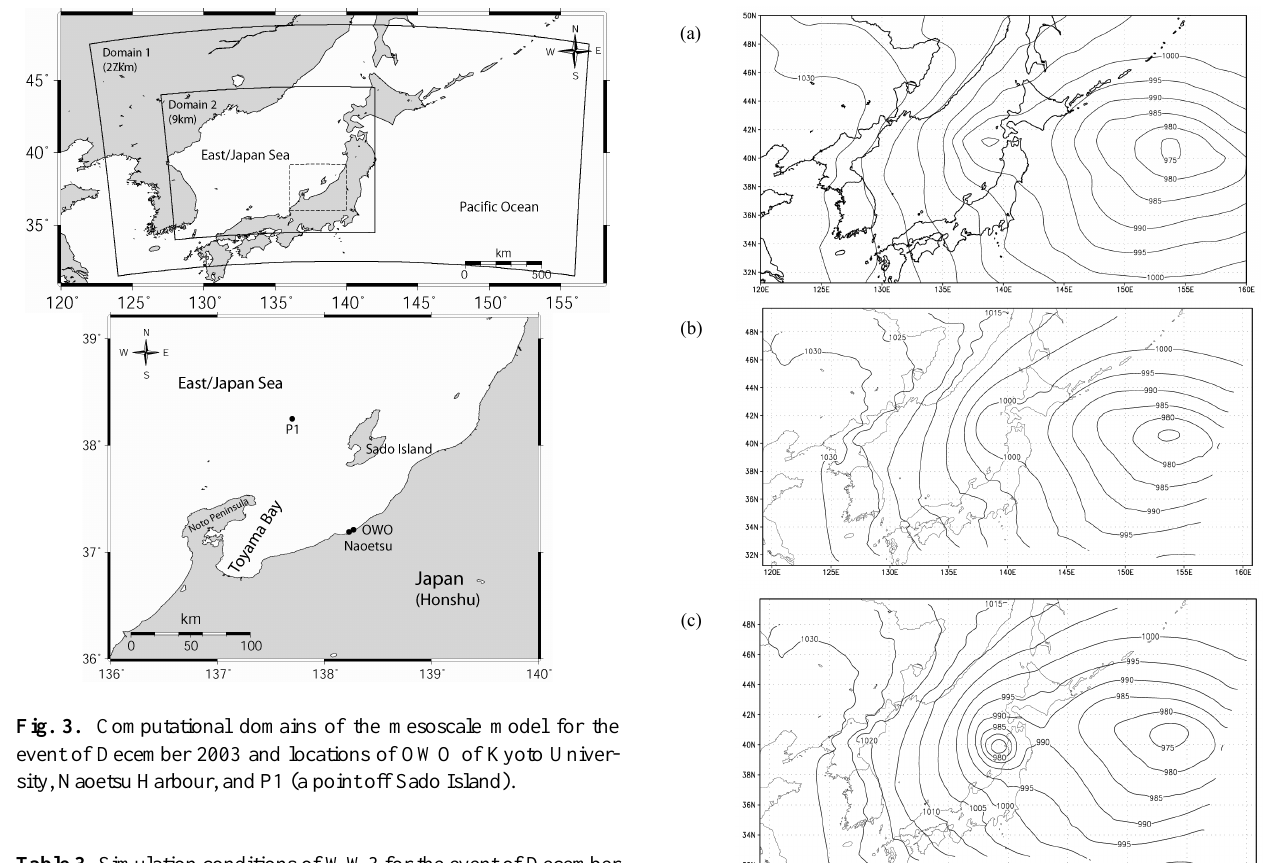
Table 3. Simulation conditions of WW3 for the event of December 2003.